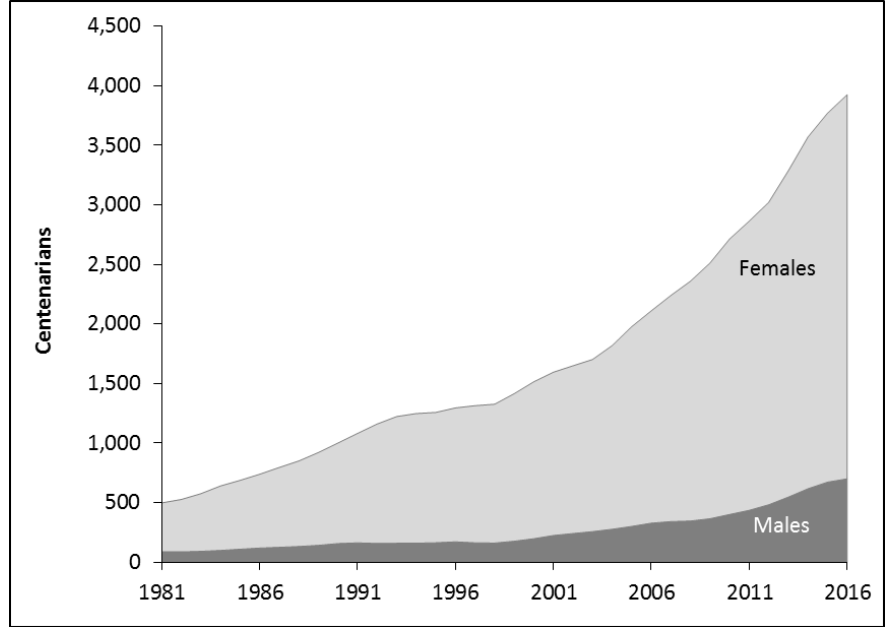
Figure 4: Growth in Australia’s centenarian population by sex, 1981 to 2016